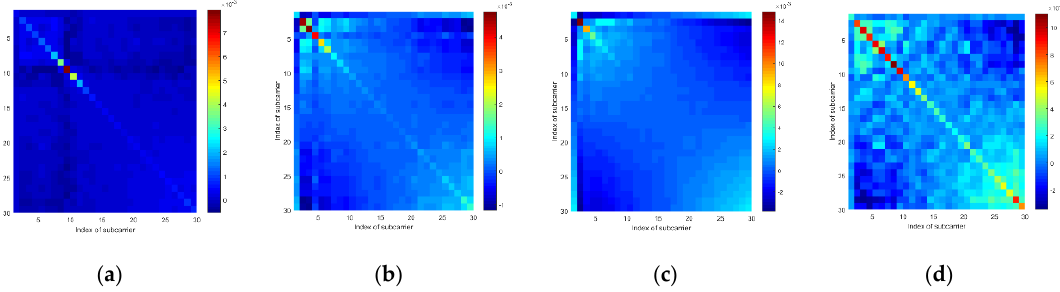
Figure 6. The CSI amplitude’s covariance matrices of a communication link tested at 4 different locations: ( a ) Location 1, ( b ) Location 2, ( c ) Location 3, and ( d ) Location 4.